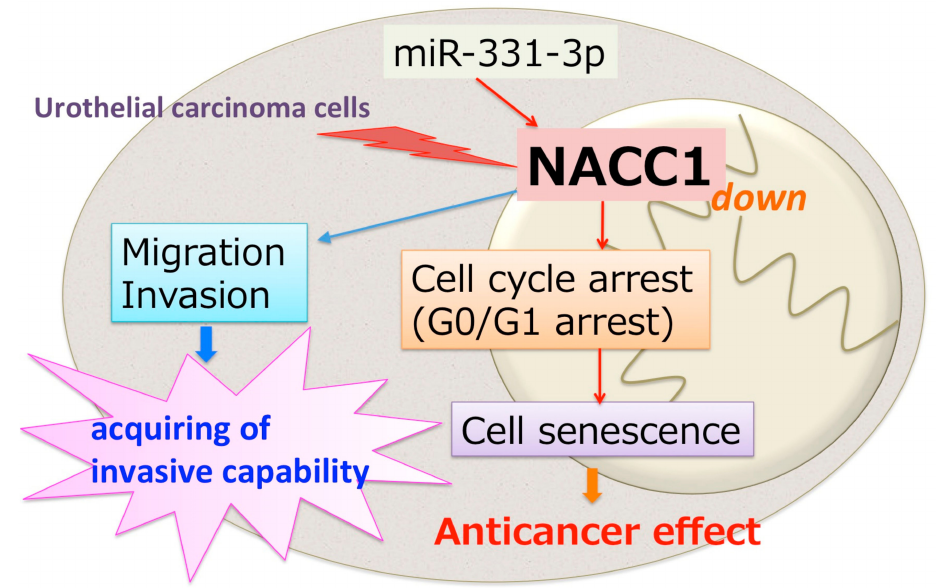
Figure 7. Suppression of NACC1 induces cell cycle arrest at G0/G1 phase and cell senescence in UC. On the other hand, NACC1 promotes cell migration and invasion